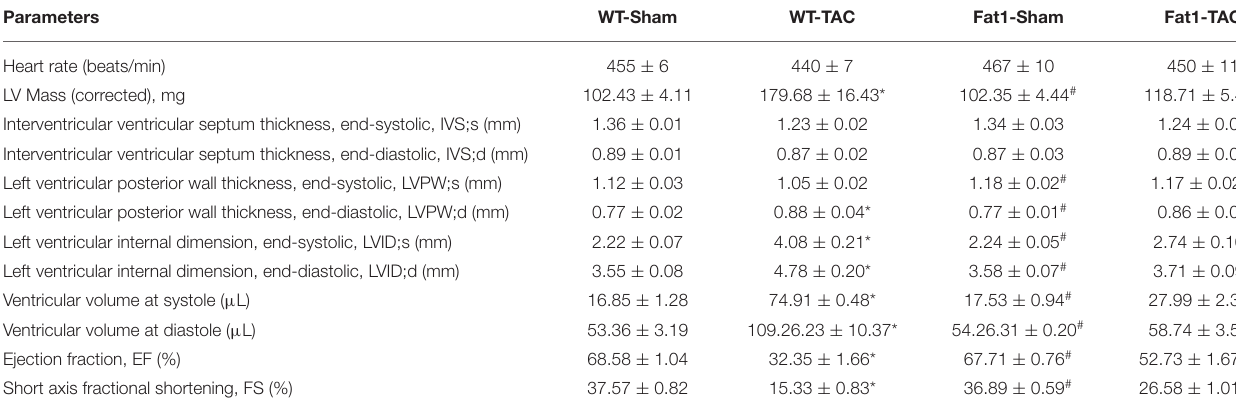
TABLE 1 | Echocardiographic measurements.